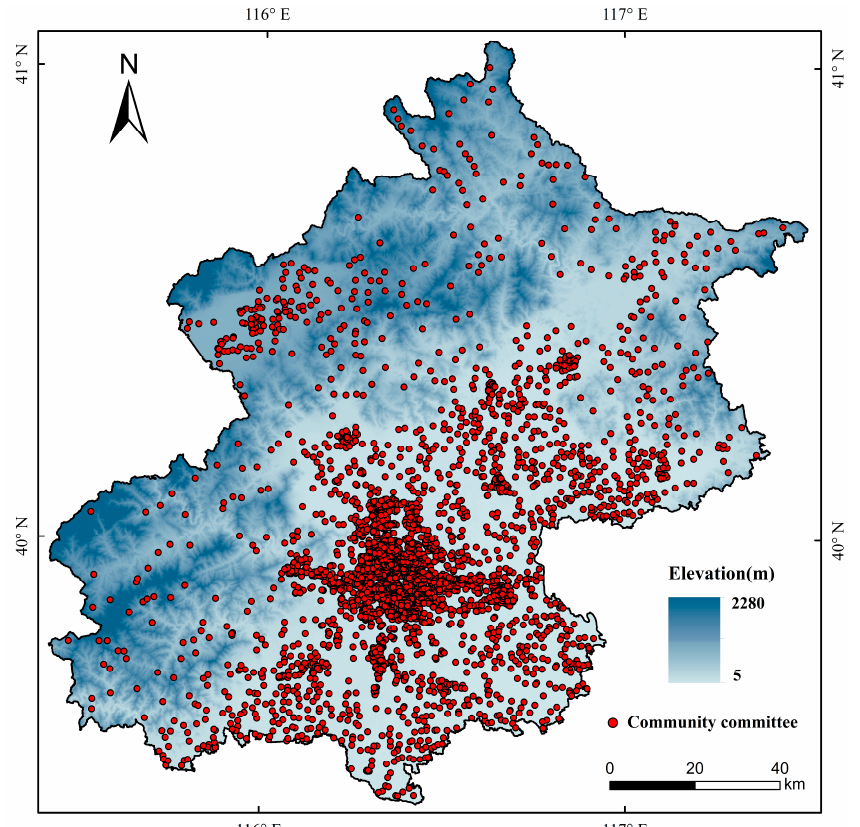
Figure 2. Spatial distribution of Beijing community committee